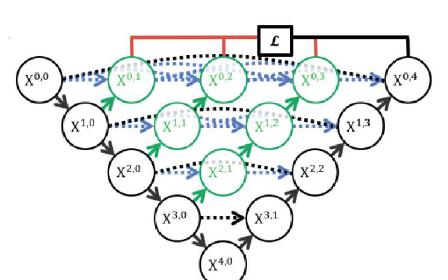
Figure 4 . Decision-level data fusion